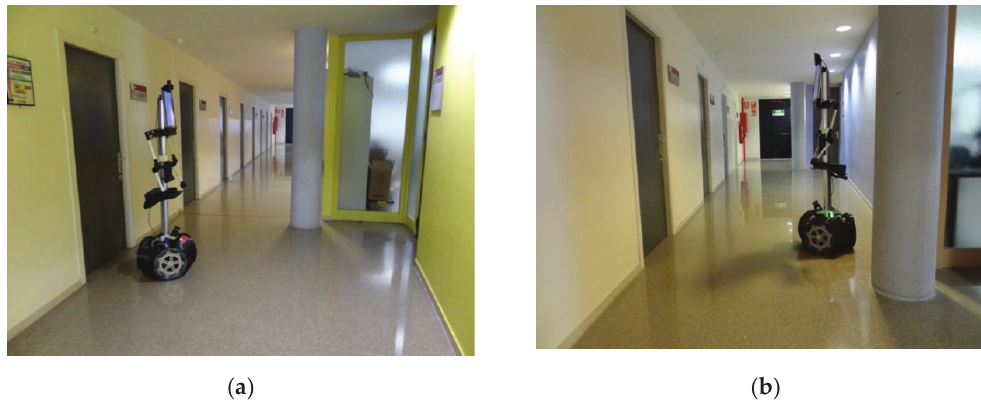
Figure 12. Mobile robot APR-03 in the corridor: ( a ) at the right side and ( b ) at the left side.